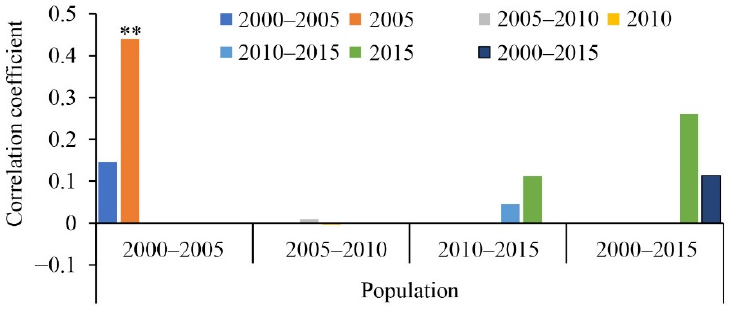
Figure 6. Bivariate correlation between changes in park access and population urbanization (** denote the significance of correlation coefficient estimate at the 0.01